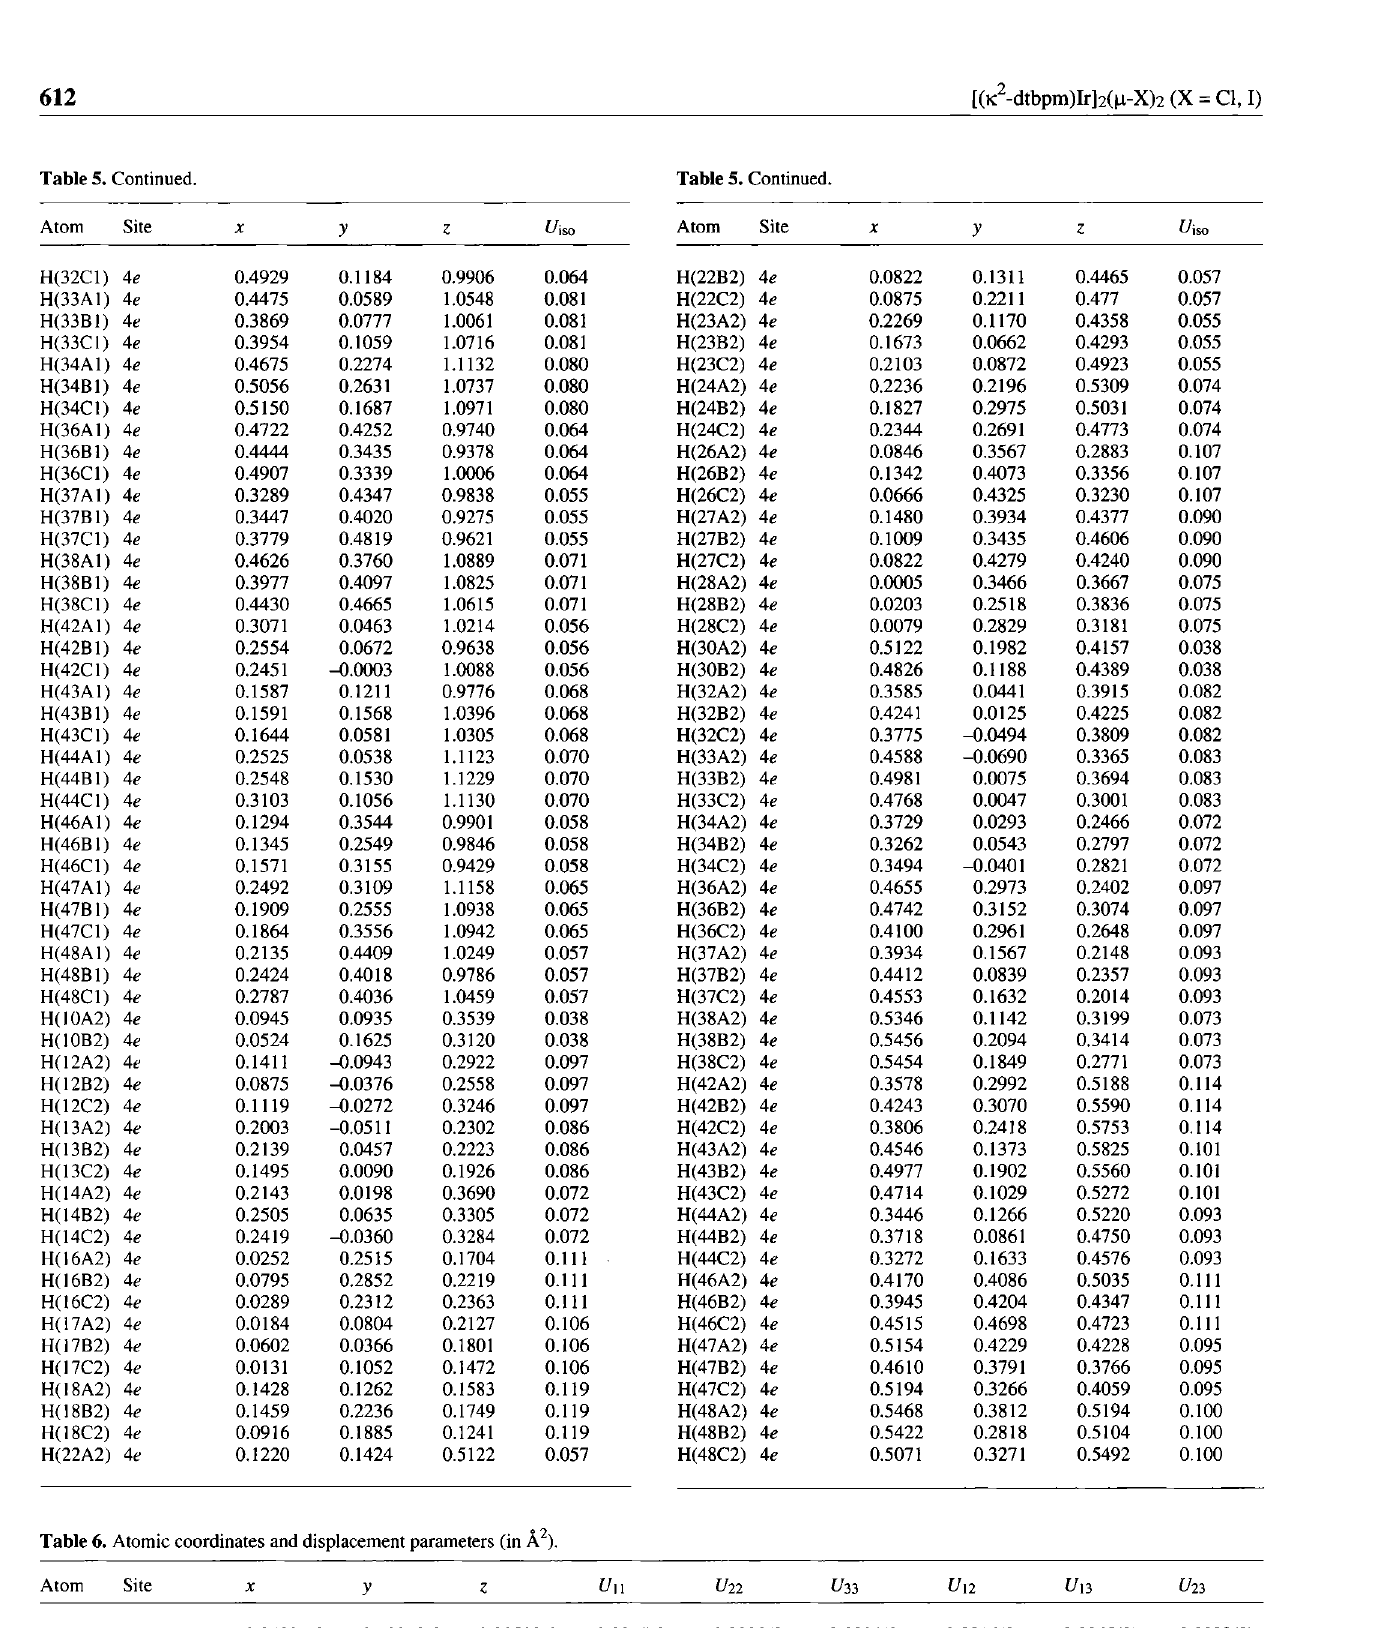
Table 6. Atomic coordinates and displacement parameters (in Ä 2